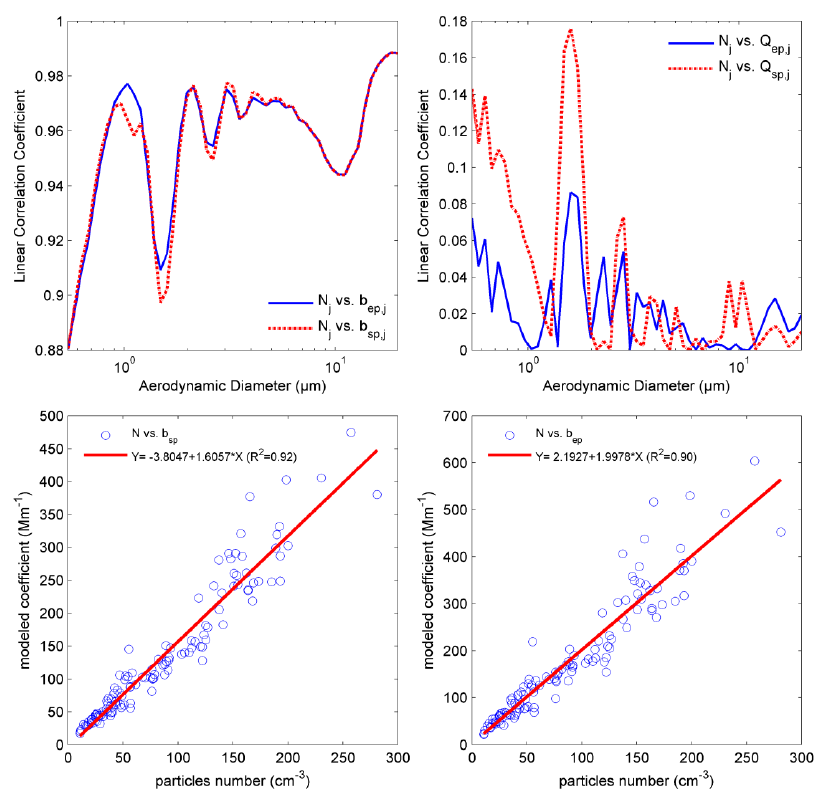
Figure 6 Linear regression between particles number and optical 437 Fig. 6. Linear regressions between particles number and optical properties of PM 0 . 5 − 20 . property of PM 0.5-20 438 Table 4. Potential uncertainties of the model estimation. Property